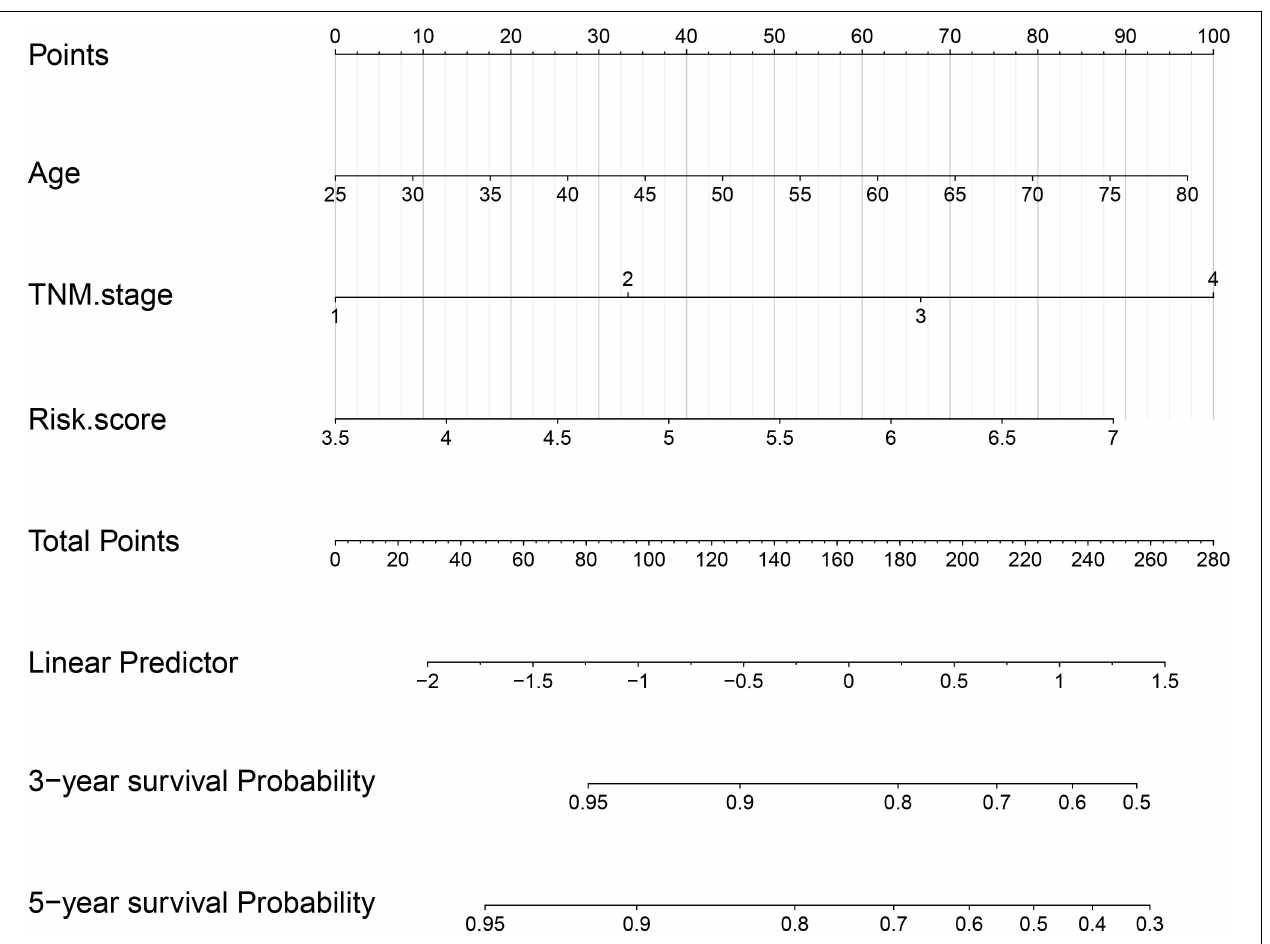
FIGURE 9 | Nomogram construction integrated with risk score, age at diagnosis, and TNM stage to estimate the 3-year and 5-year survival probability for HBV carriers with HCC development.